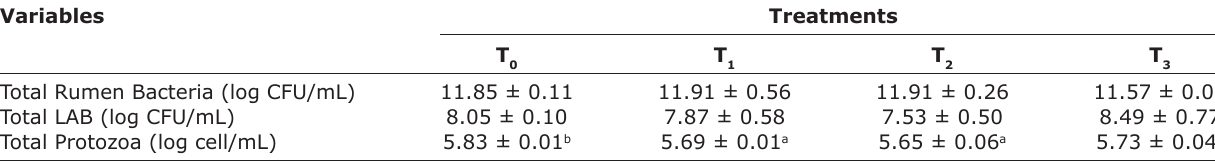
Table-3: Population of rumen microbes from in vitro rumen fermentation supplemented with probiotic.